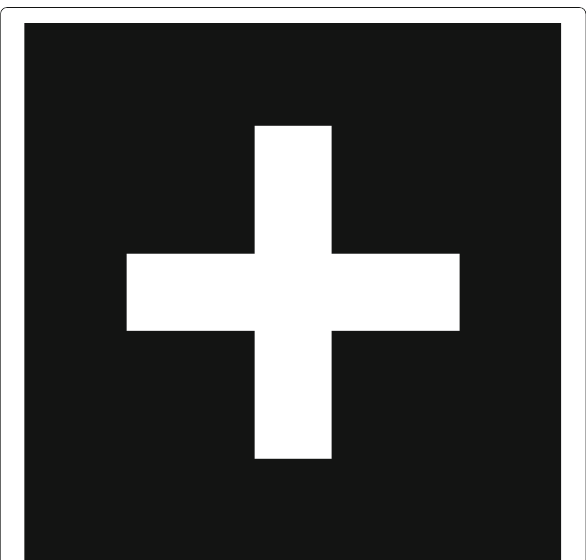
Algorithm 1 MAP- H 1 in Fourier domain